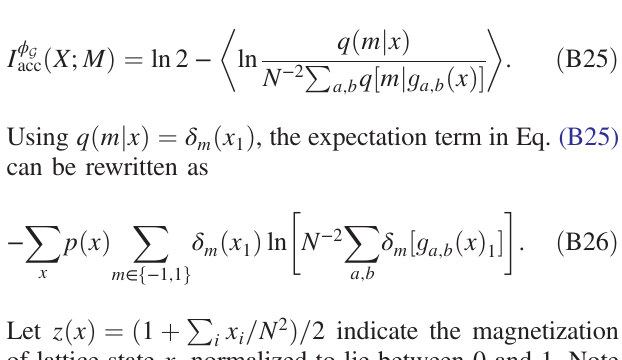
FIG. 16. A unicyclic master equation over 12 states with fourfold symmetry, as in Eq. (B23). Left: an initial distribution p ð x Þ ∝ x , which does not respect the fourfold symmetry. Right: the twirling ϕ G ð p Þ , which is invariant to the symmetry. (Colors indicate relative probability assigned to each of the 12 states.) The extractable work depends on the accessible free energy in p , ϕ which is given by F G ð p Þ(cid:2) E ½